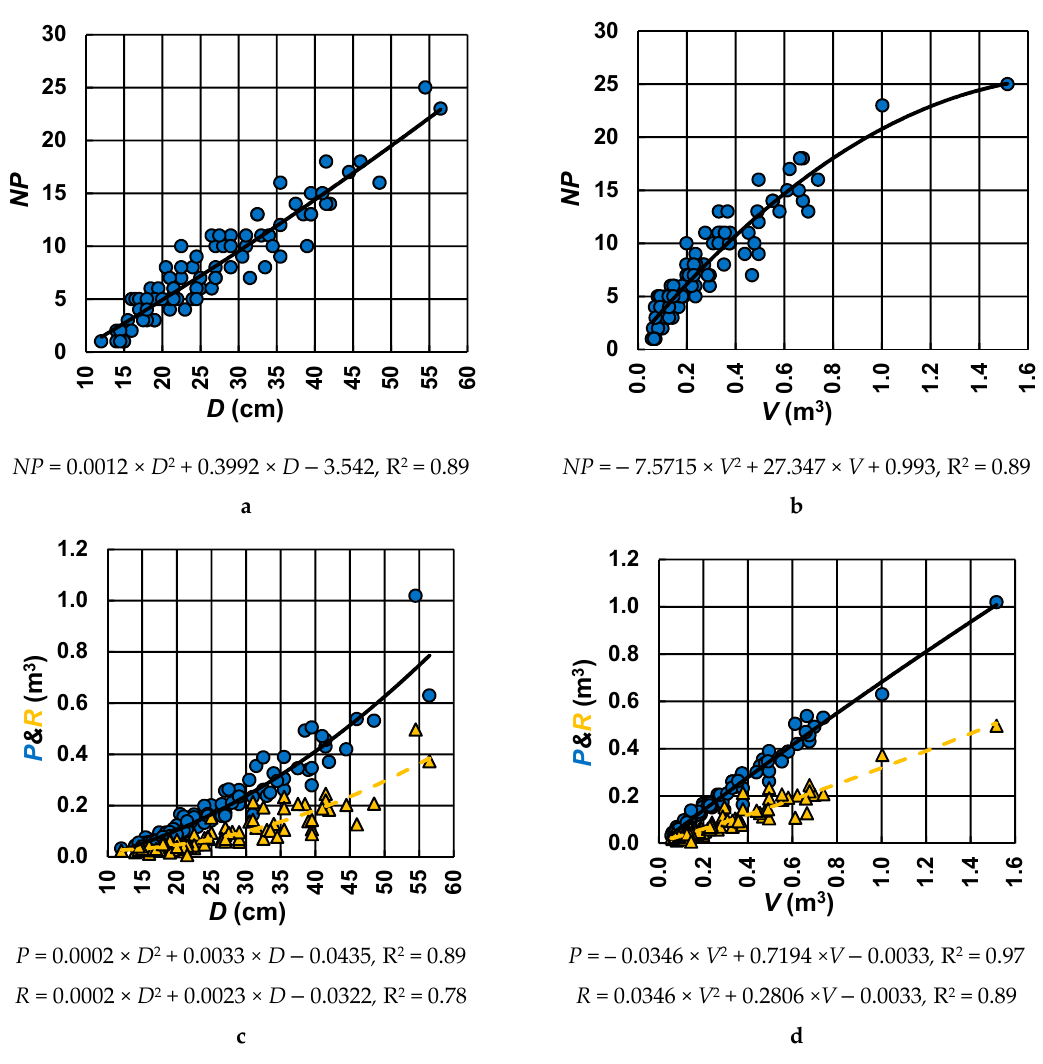
Figure 2. Dependence relations between the production variables and production inputs. Legend: ( a ) and ( b )—number of produced pieces ( NP ) as a function of the average diameter ( D ) and log volume ( V ); ( c ) and ( d )—volume of production ( P ) and residues ( R ) as a function of the average log diameter ( D ) and log volume ( V ).